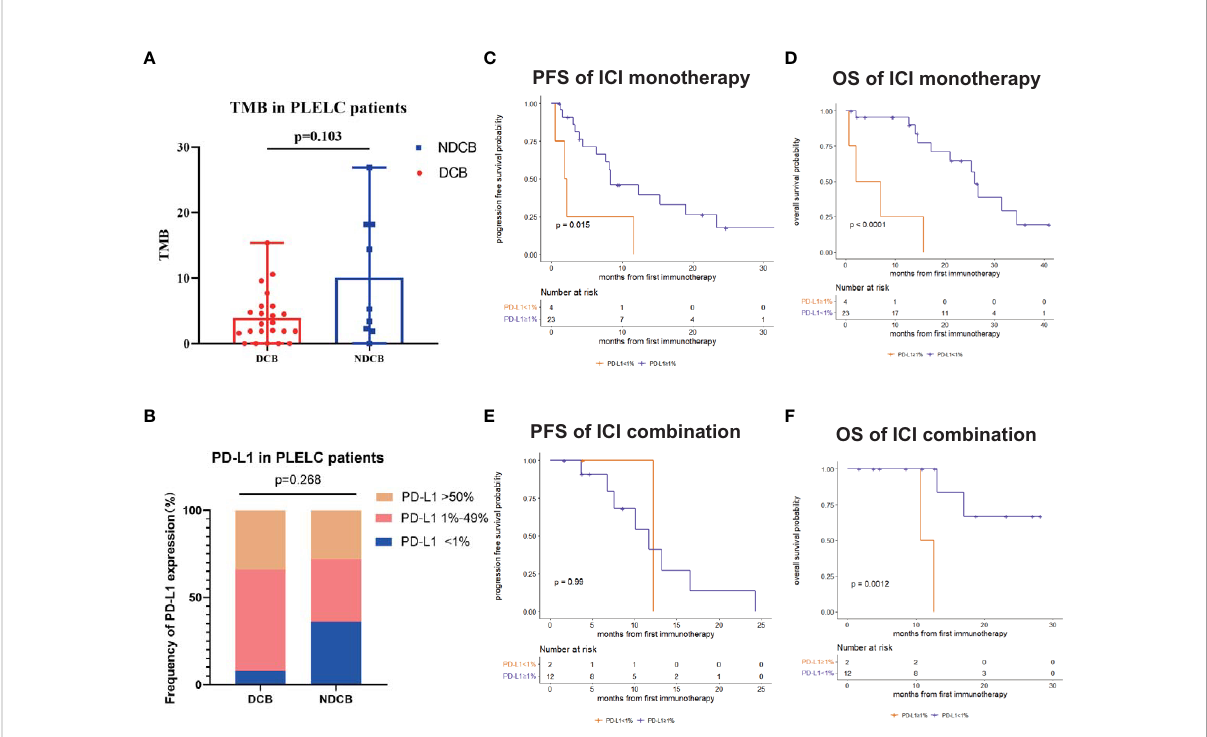
FIGURE 2 Predictive and prognostic signi fi cance of PD-L1 and TMB in PLELC. (A) TMB levels in ICI-treated PLELC-DCB patients versus NDCB patients. (B) Proportion of different PD-L1 expression in DCB patients versus NDCB patients. (C, D) PFS and OS of patients with PD-L1 <1% versus ≥ 1% in PLELC patients treated with ICI monotherapy. (E, F) PFS and OS of patients with PD-L1 <1% versus ≥ 1% in PLELC patients treated with ICI combination